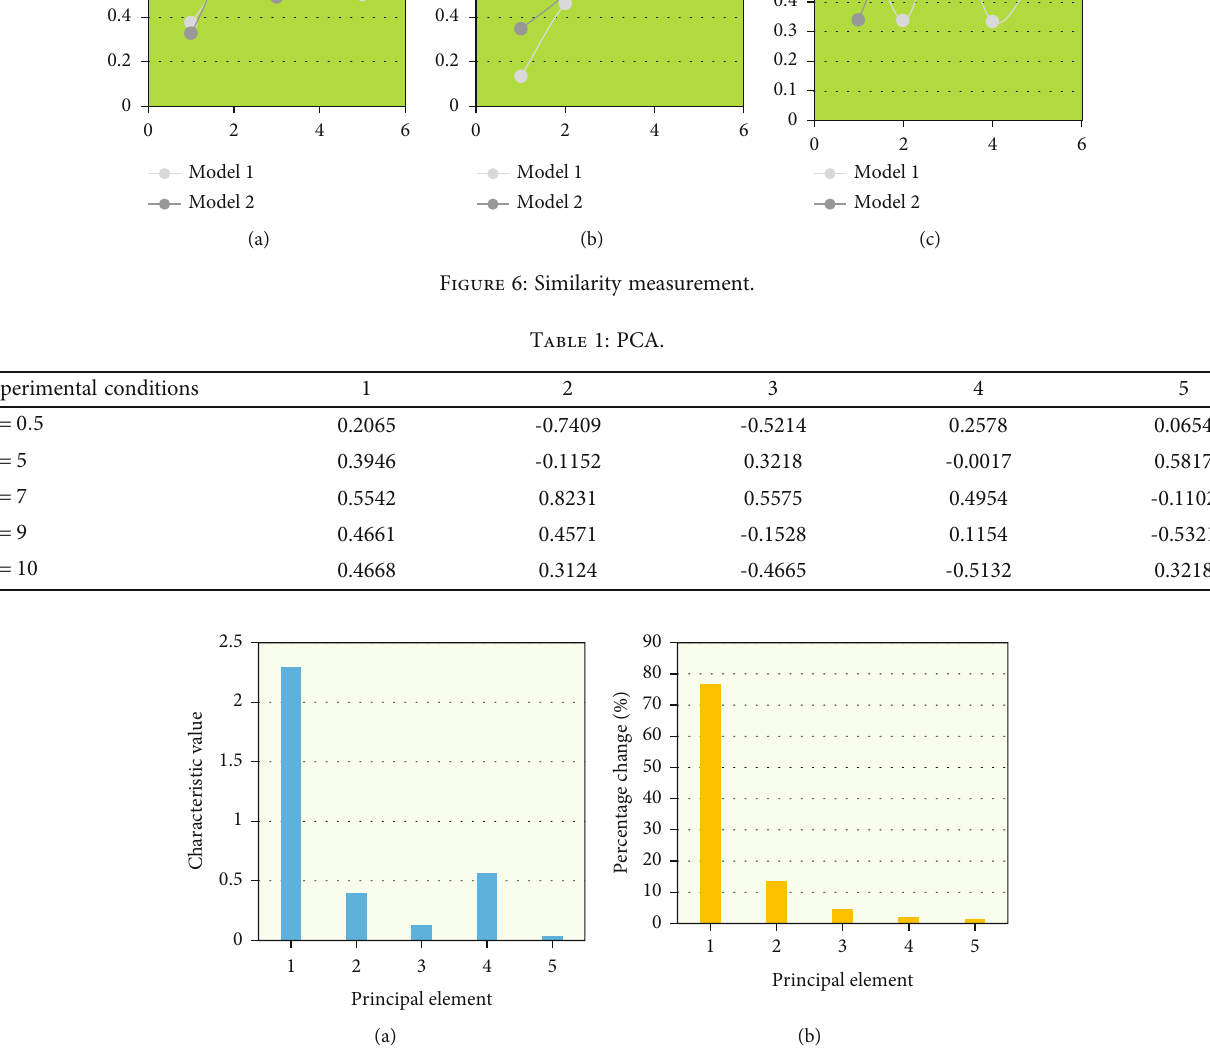
Figure 7: Changes of characteristic values corresponding to di ff erent